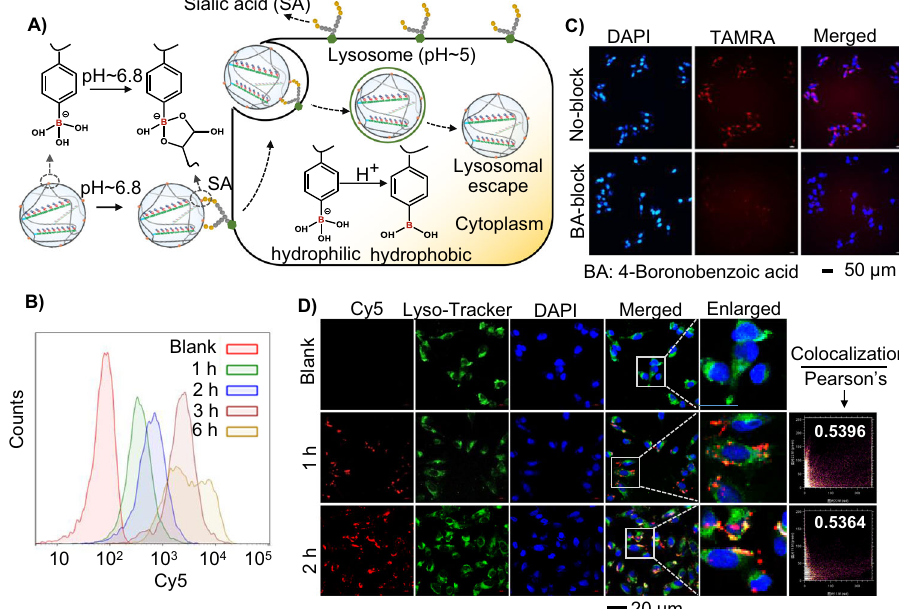
Fig. 4 PBA mediating cellular uptake and lysosomal escape of DPNF. A Schematic illustration of PBA mediating cellular uptake and lysosomal escape of DPNFs. B Flow cytometry analysis of cellular uptake of Cy5-SDPNF-20 (420 μ g/ml) by MBA-MD-231 cells at different incubation time. C CLSM images of TAMRA-SDPNF-20 treated MBA-MD-231. BA-block group, cells were pretreated with 4-boronobenzoic acid (BA, 0.2 mg/ml) and then incubated with TAMRA-SDPNF-20 (420 μ g/ml); No-block group, cells were incubated with TAMRA-DPNF-20 without BA pretreatment. D CLSM images of MBA-MD- 231 cells incubated with Cy5-DPNF-20 (420 μ g/ml) at different time points. Cellular nuclei (blue) were stained by 4 ′ ,6-diamidino-2-phenylindole (DAPI) and lysosomes were stained with LysoTracker Green.